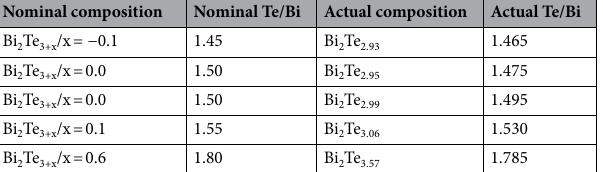
Nominal composition Nominal Te/Bi Actual composition Actual Te/Bi Bi 2 Te 3+x /x = −0.1 1.45 Bi 2 Te 3+x /x = 0.0 Bi 2 Te 3+x /x =